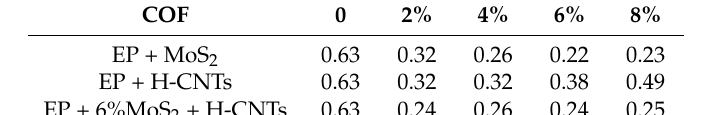
Table 2. Coefficient of friction of composites with different contents of various additives.